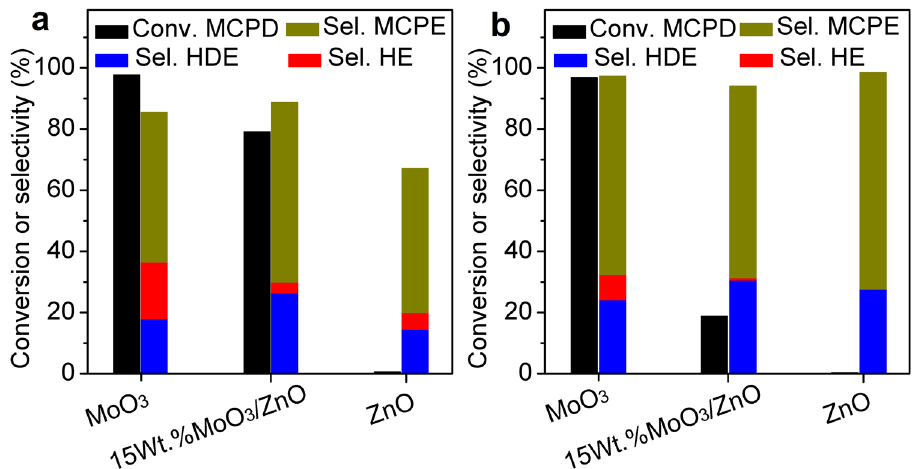
Fig. 3 Hydrogenation performance of various catalysts. a MCPD was used as feedstock, b acetone + MCPD (initial acetone/MCPD molar ratio = 1) was used as feedstock. Conditions: T = 400 °C, PH 2 = 0.1 MPa, WHSV = 0.23 g g − 1 h − 1 , initial H 2 /MCPD molar ratio is 40. MCPD methylcyclopentadiene, MCPE methylcyclopentene, HDE hexadienes,